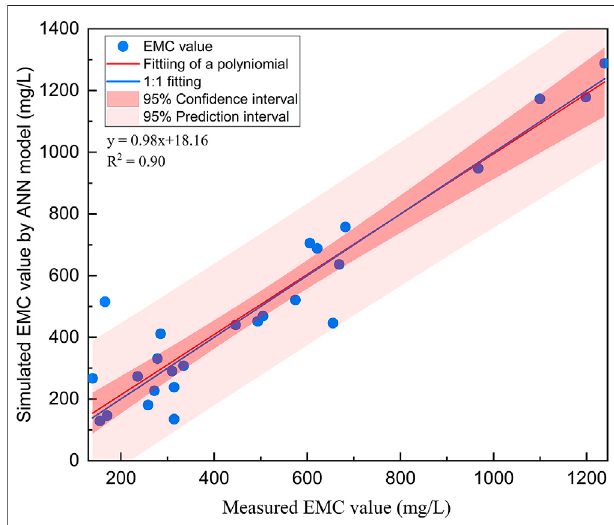
FIGURE 8 | Plot showing the ANN training performance.